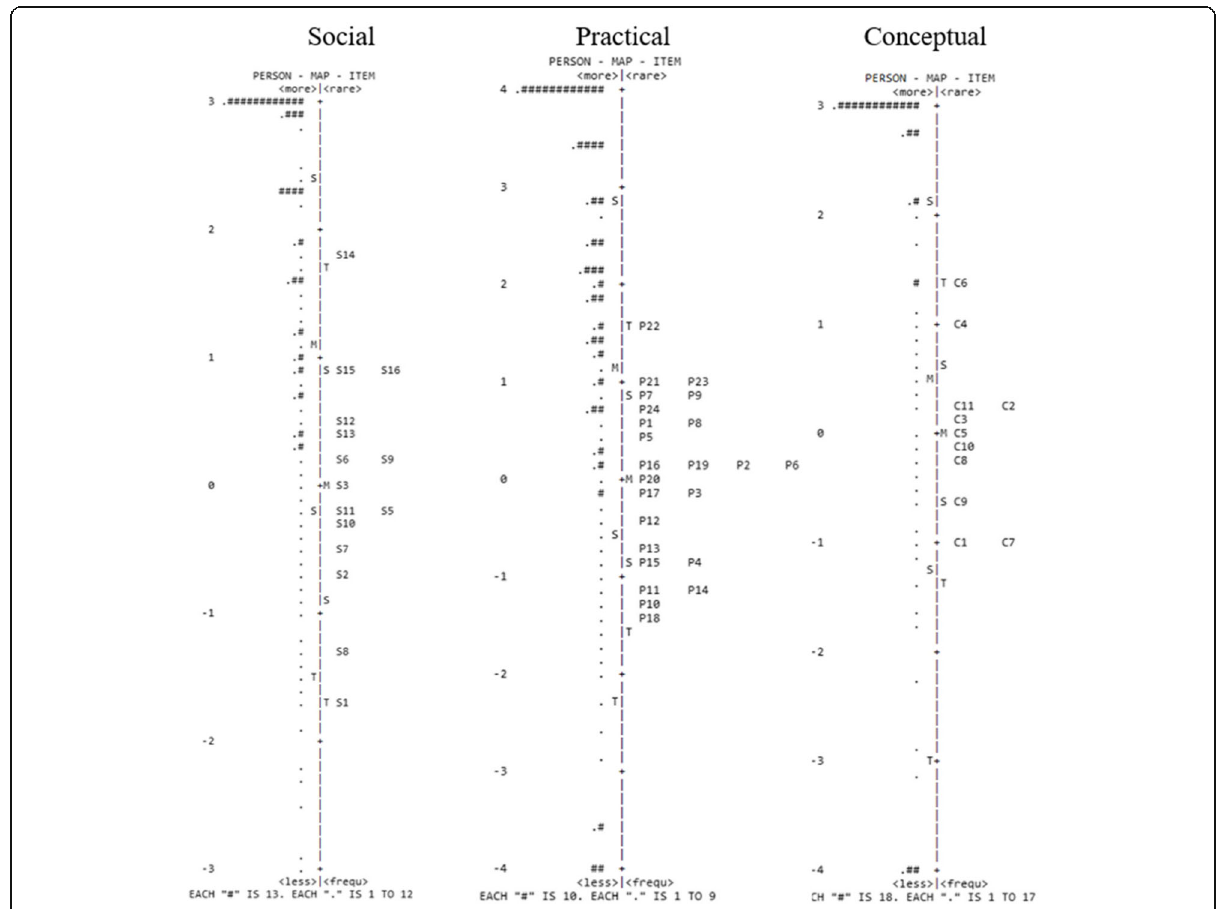
Fig. 3 Item-person map of the EFA-DI ’ s social, practical, and conceptual domains. M, mean; S, 1st standard deviation; T, 2nd standard deviation; number sign indicates group of 15 people; full spots indicates group from 1 to 14 people